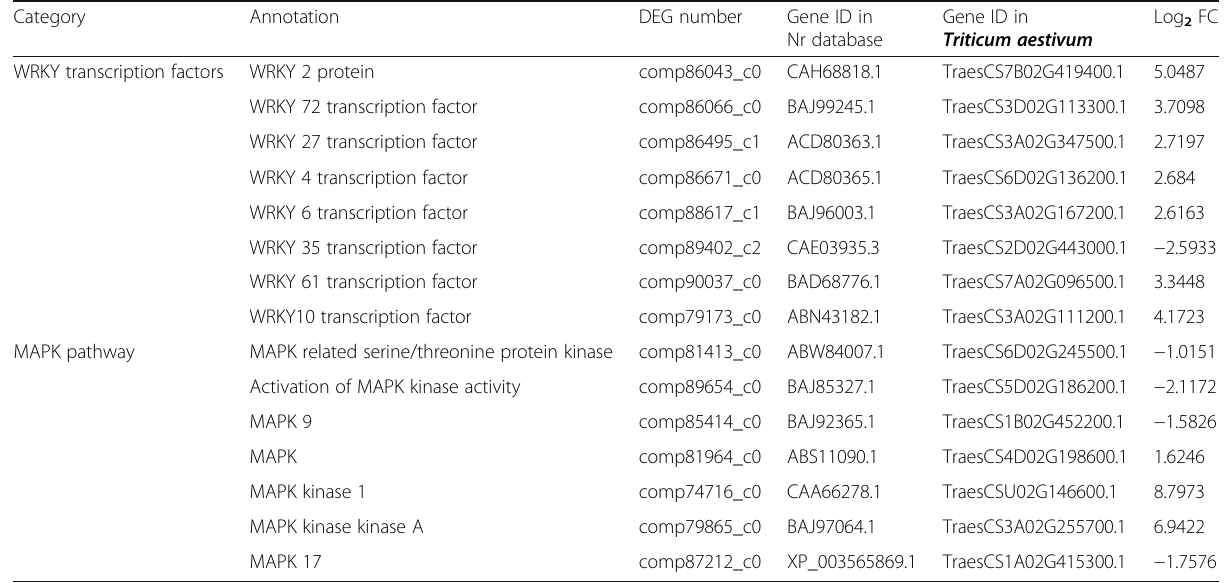
Table 1 DEGs involved in defense regulation Category